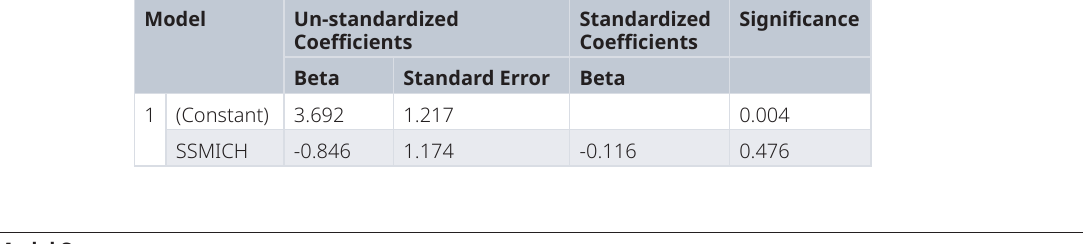
Table 3a. Model Summary.